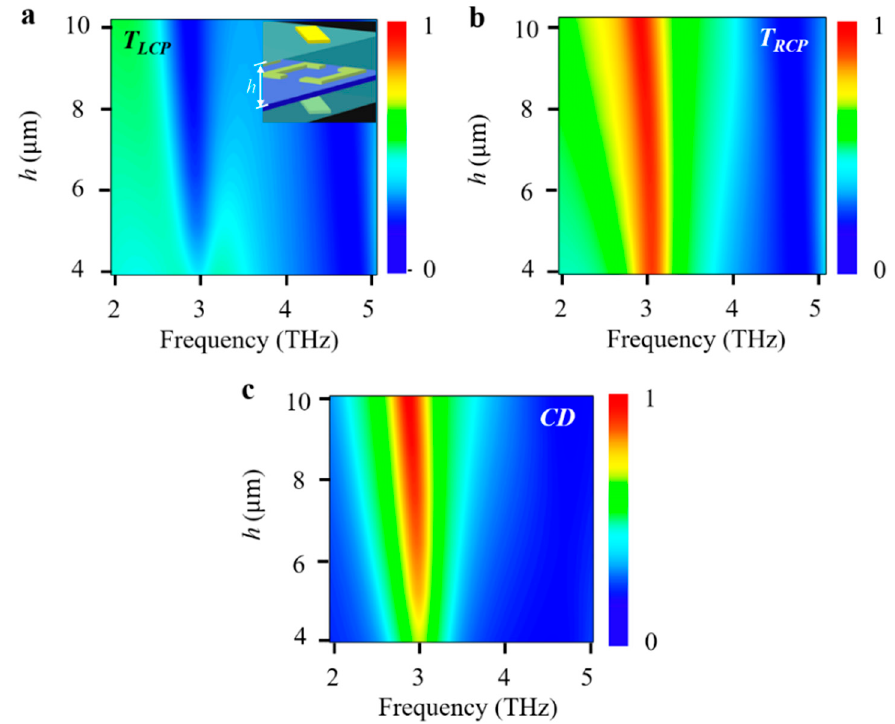
Figure 6. The calculated transmission spectra versus height h for the illumination of ( a ) LCP light and ( b ) RCP light. ( c ) The calculated corresponding CD response spectra versus different height h . The inset in ( a ) depicts the related geometric parameter and VO 2 is in the isolating state.